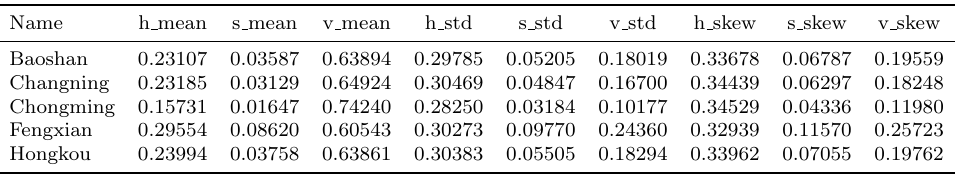
Table 6: Partial colour features identified in